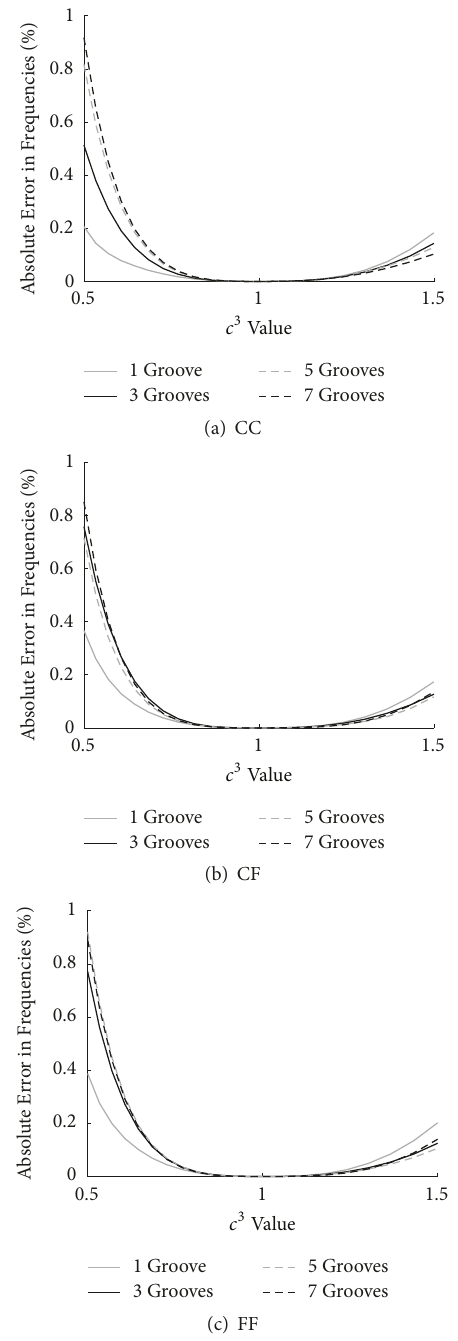
Figure 10: Frequency error results for variable 𝑐 using the norm minimization of the